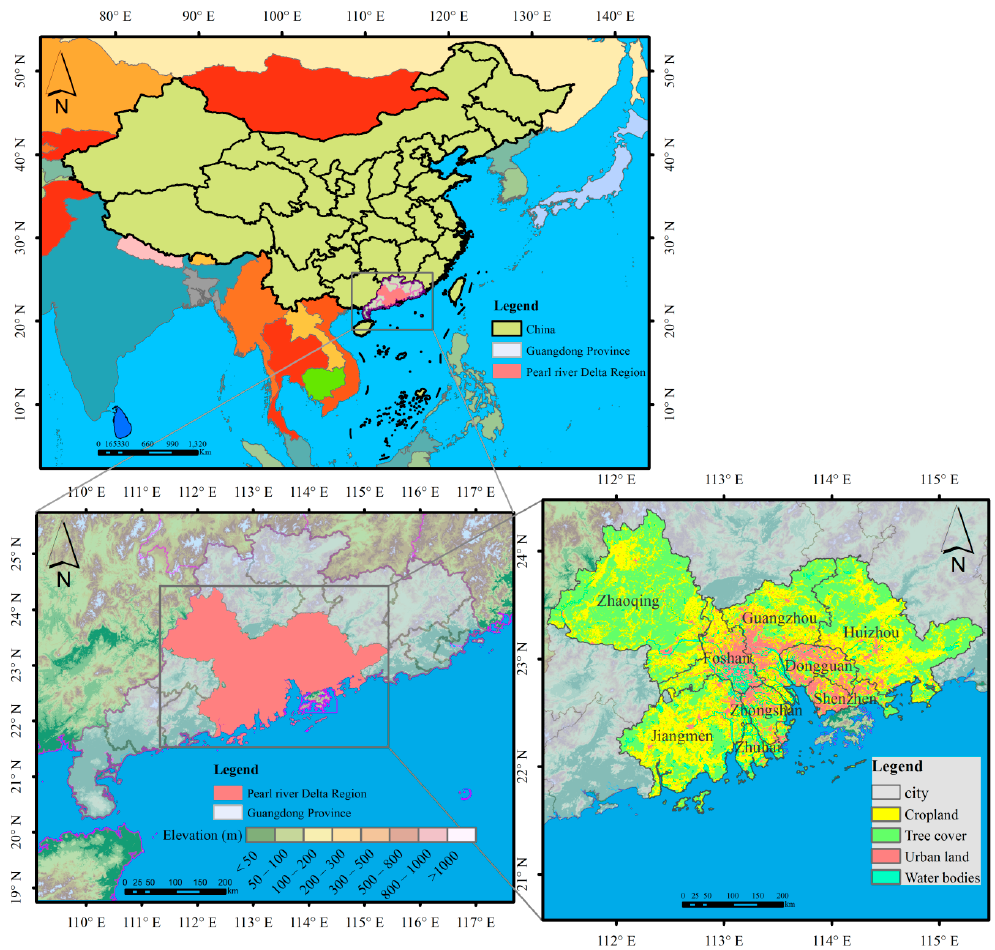
Figure 1. Location of the PRD region.